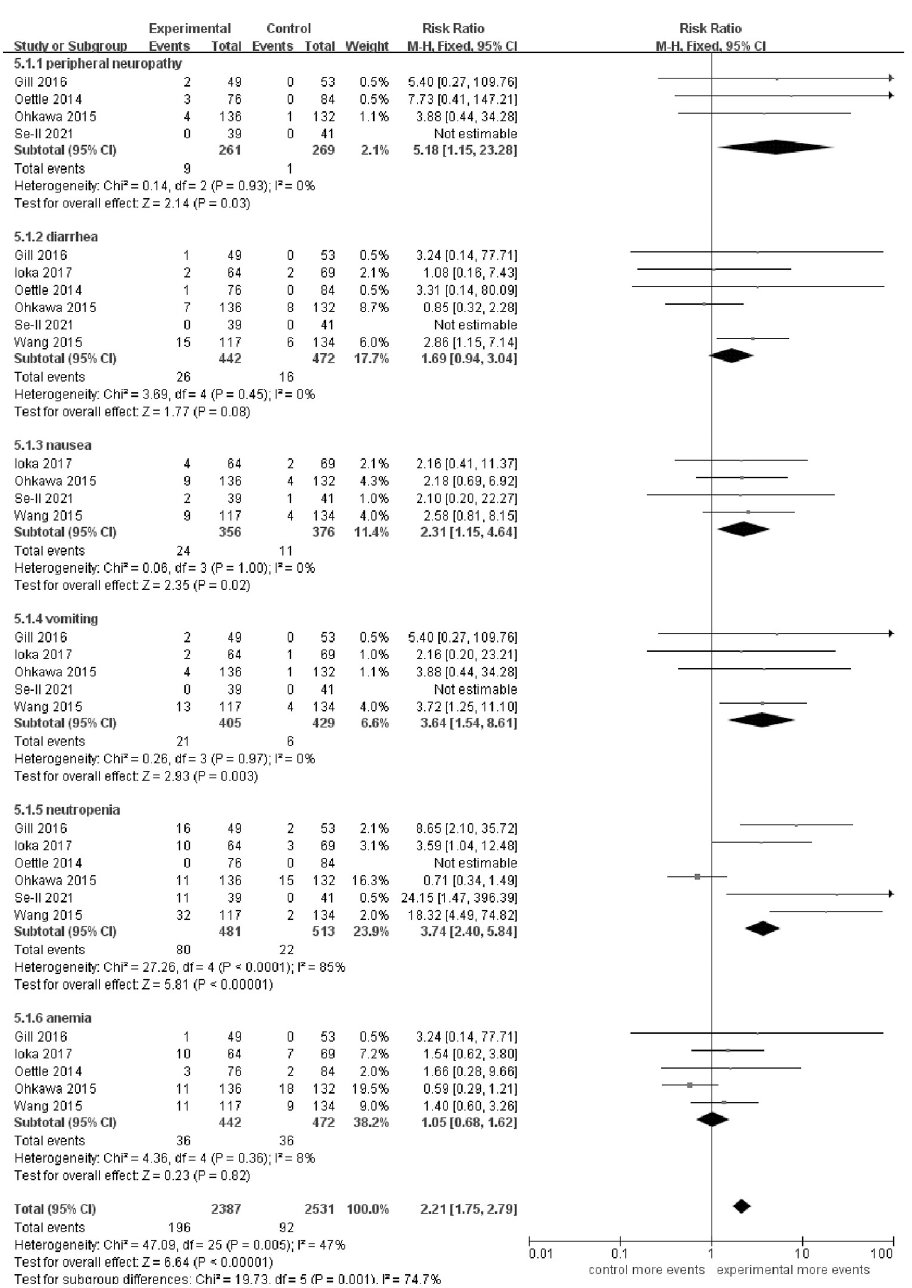
Fig 5. Comparison of toxicities between fluoropyrimidine combination therapy and fluoropyrimidine monotherapy. CI: Confidence interval. Diamonds represented the 95% confidence interval of overall effect.